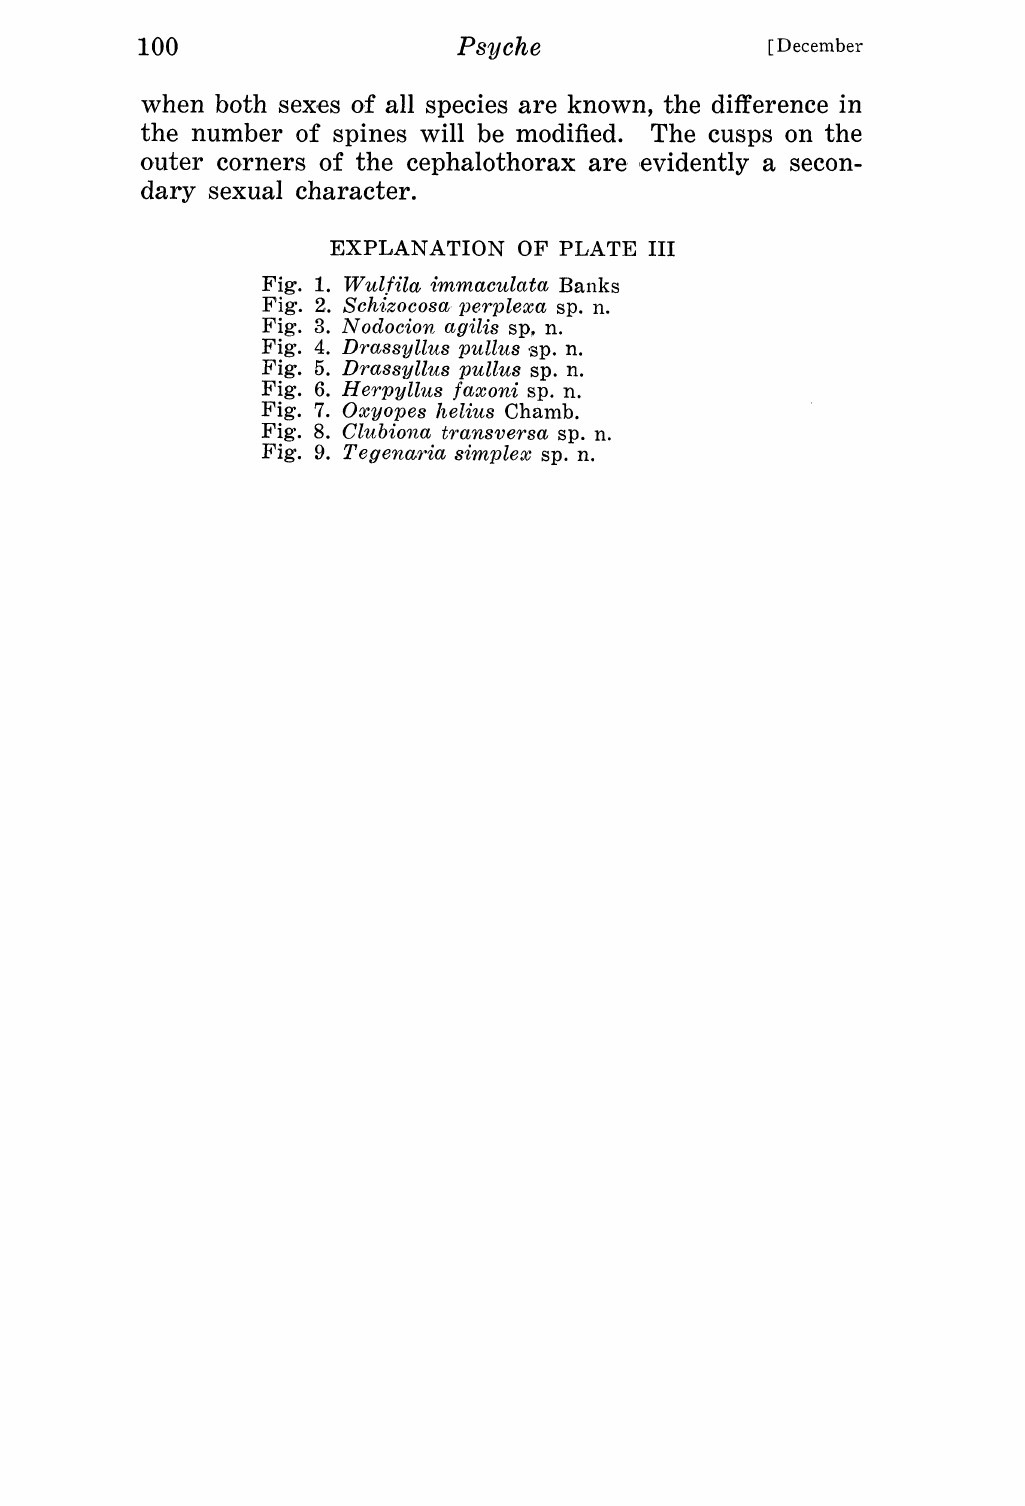
Fig’. 1. Wulfila immaculata Banks Fig. 2.. Schizocosa. perplexa sp. n. Fig. 3. Nodocion agilis sp, n. Fig. 4. Drassyllus pullus sp. n. Fig’. 5. Drassyllus pullus sp. n. Fig. 6. Herpyllus faxoni sp. n. Fig. 7. Oxyopes helius Chamb. Fig. 8. Clubiona transversa sp. n. Fig. 9. Tegenaria simplex sp.